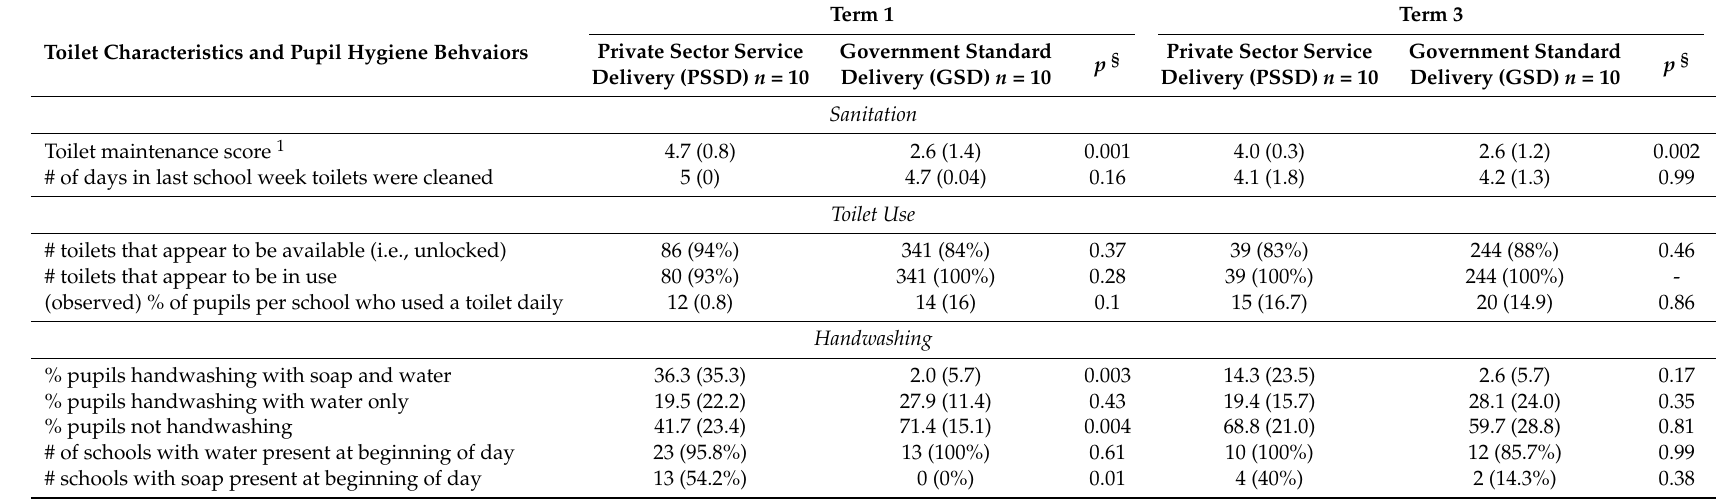
Table 2. Toilet characteristics and pupil hygiene behaviors for both trial